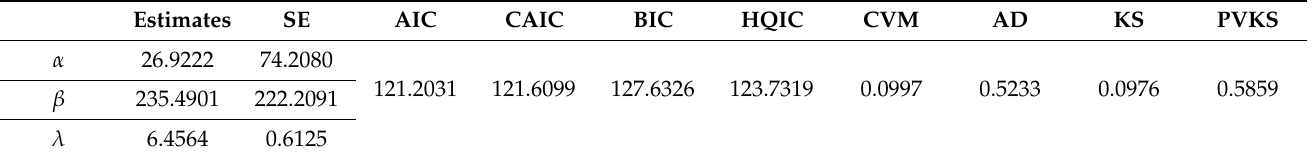
Table 7. MLE, SE, and different measures of goodness of